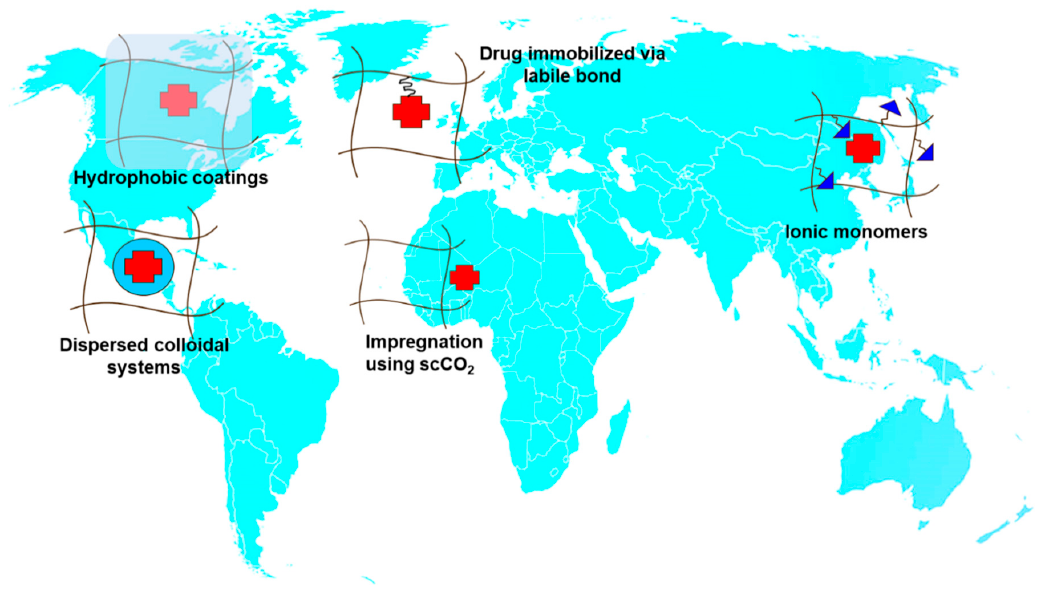
Figure 3. Worldwide strategies to produce drug-eluting contact lenses.